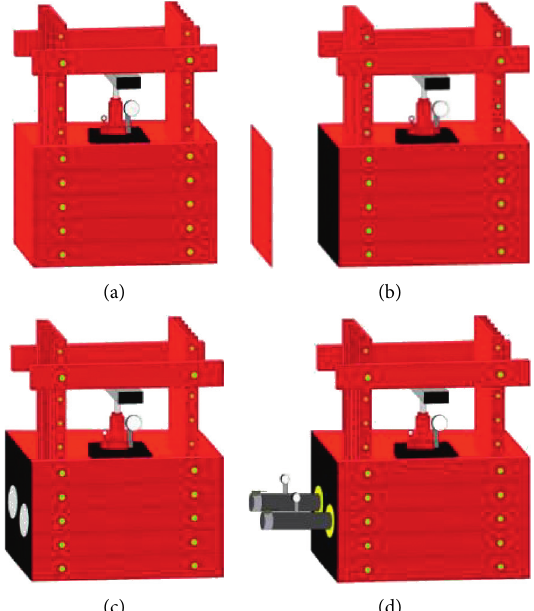
Figure 6: Test procedure of material sealing performance.